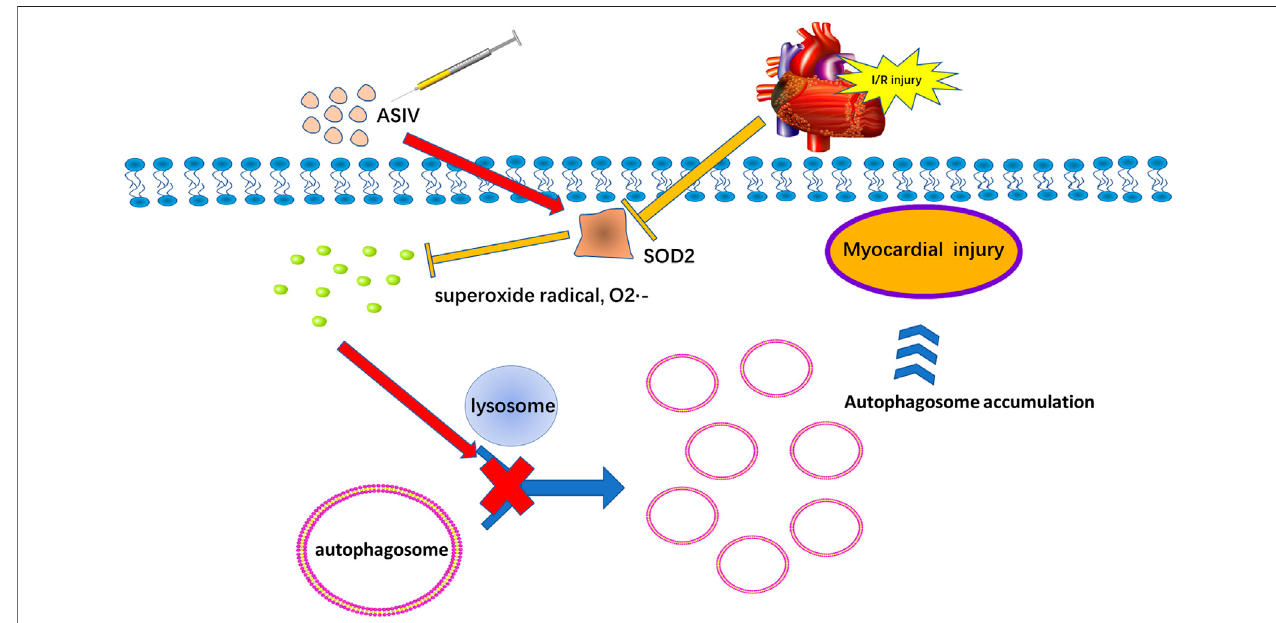
FIGURE8| PotentialmechanismofASIVonmyocardialischemia-reperfusioninjuryviaattenuatingsuperoxideanion-mediatedaccumulationofautophagosomes.